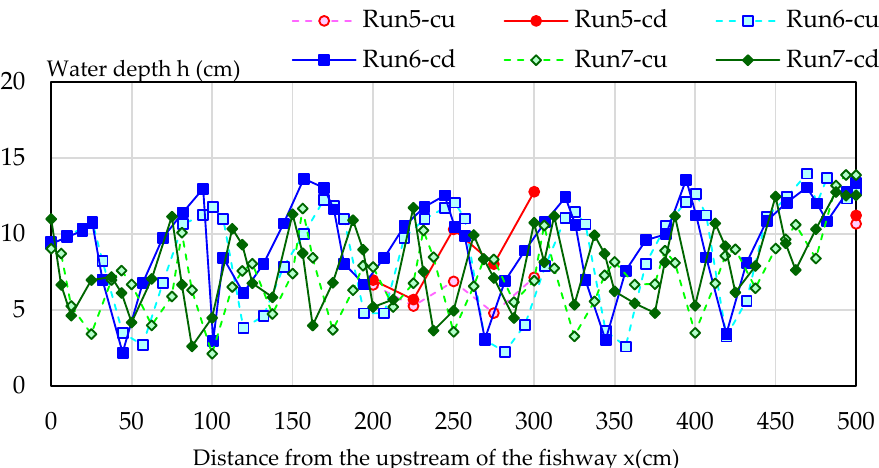
Figure 14. Water surface profile in the fishway (y = 27.5 cm; the central part of the fishway).